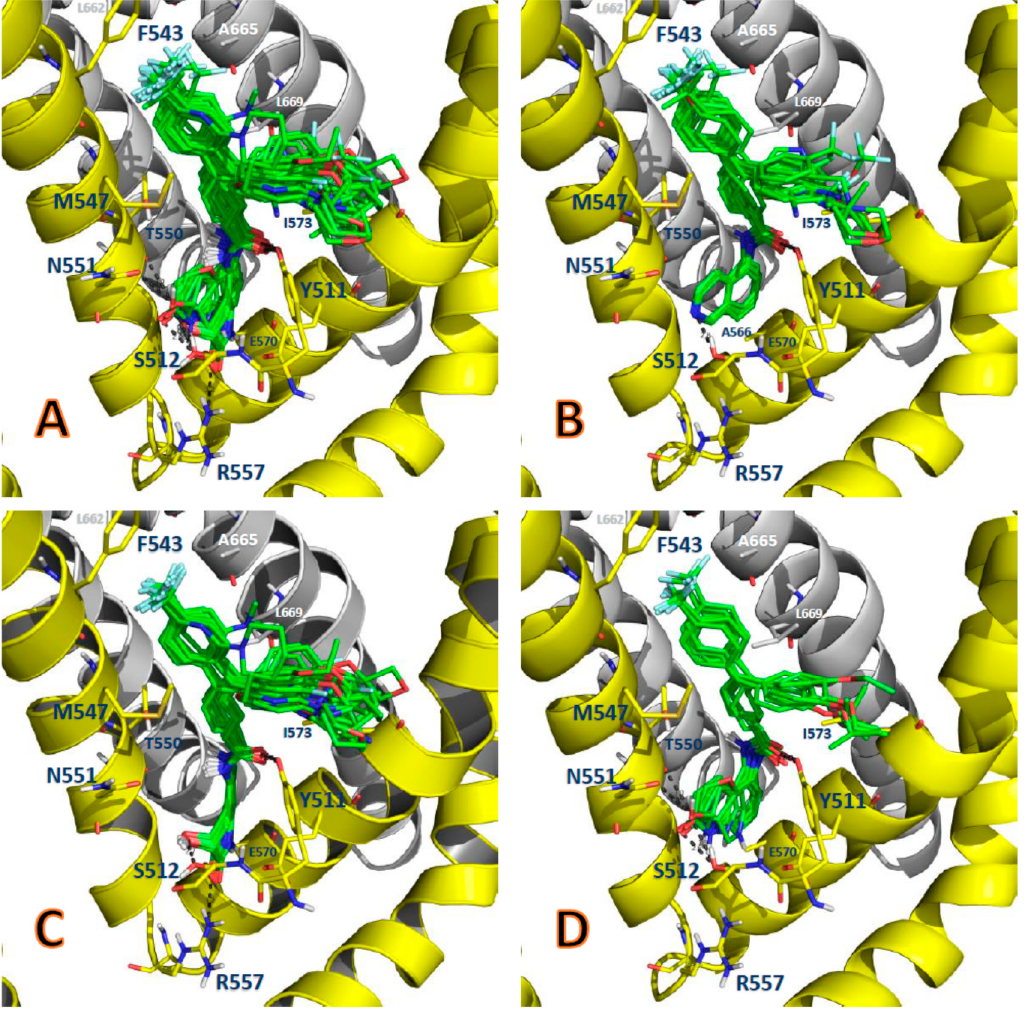
Figure 1. Binding modes of the DPDAs as TRPV1 antagonists. ( A ) Binding modes of the whole dataset. ( B ) Binding modes of the compounds in series A. ( C ) Binding modes of the compounds in series B. ( D ) Binding modes of the compounds in series C. The DPDAs are represented as green sticks, chains A and B of TRPV1 are represented as yellow and gray cartoon representations, respectively. Residues from chains A and B of TRPV1 in the binding site are represented as yellow and gray sticks, respectively.